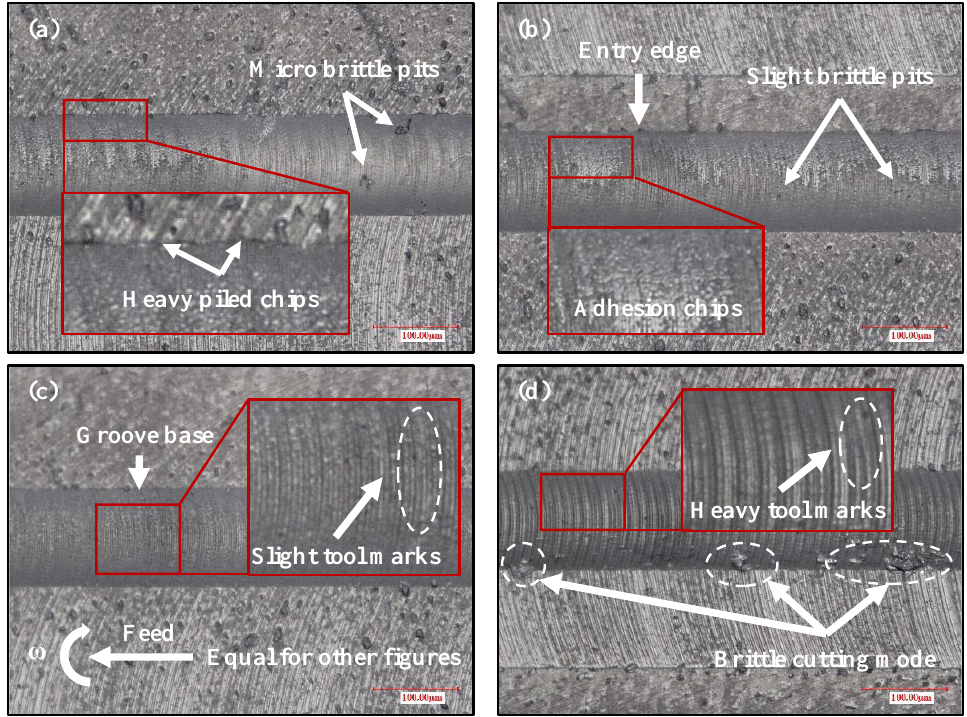
Figure 5. (Defect-free surface) Machined surface topographies of microgrooves with different feed rates per tooth: ( a ) f t = 0.27 µm/z, f t / r e = 0.15; ( b ) f t = 0.46 µm/z, f t / r e = 0.25; ( c ) f t = 1.37 µm/z, f t / r e = 0.75; ( d ) f t = 5.46 µm/z, f t / r e = 3.0.